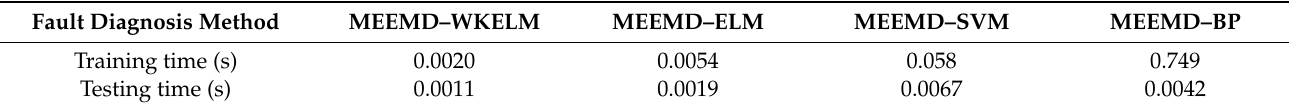
Table 6. Comparison of training time and testing time of the four fault diagnosis methods. Fault Diagnosis Method